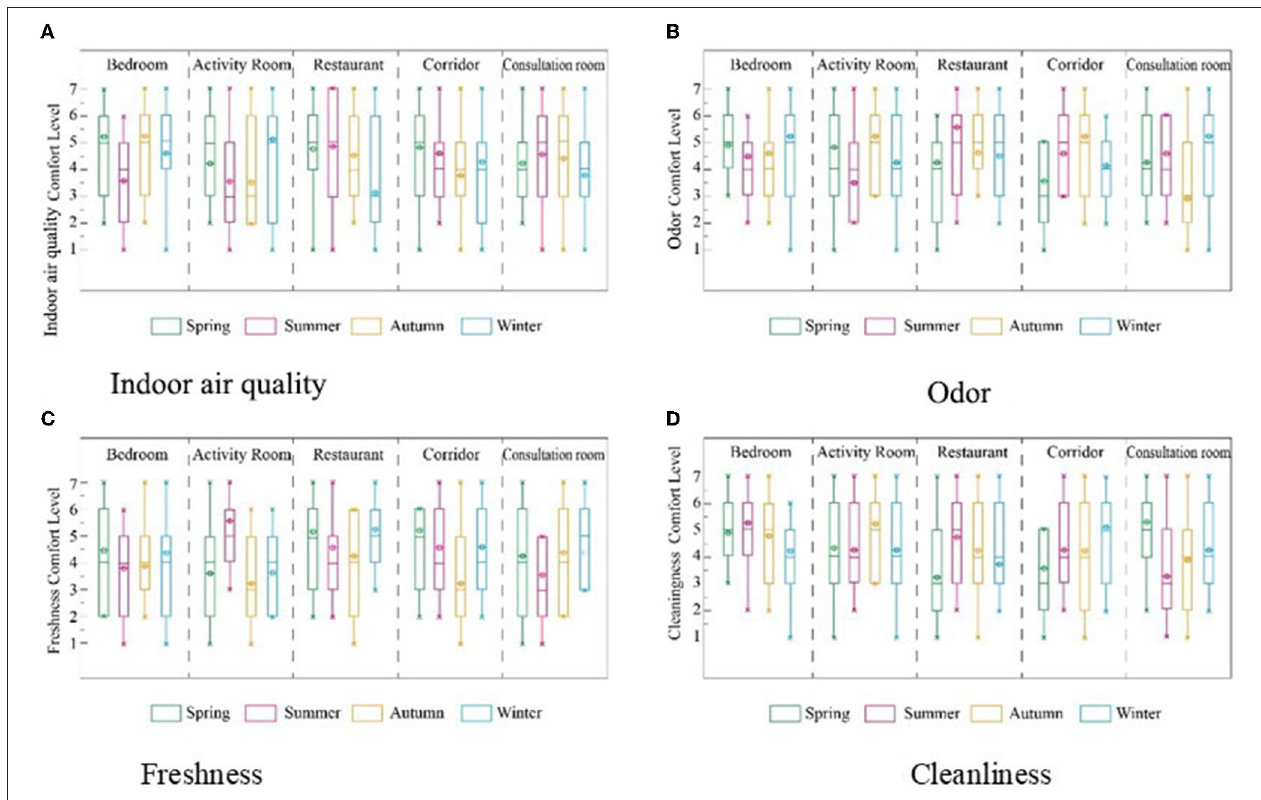
FIGURE 12 | Evaluation of air quality of 4 RECFs based on seasonal differences. (A) Indoor air quality, (B) Odor, (C) Freshness, and (D)